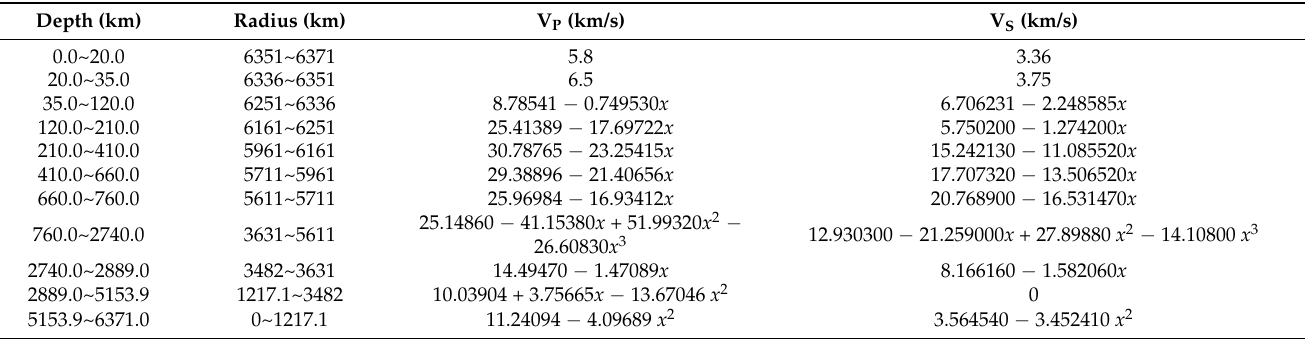
Table 1. The parameters of IASP91 Earth